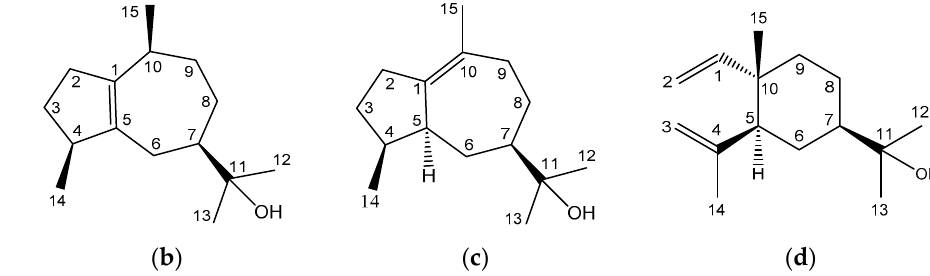
Figure 2. Chemical structures of sesquiterpenoids isolated from leaf essential oil. ( a ) 4,5-Epoxy- β - caryophyllene; ( b ) Guaiol; ( c ) Bulnesol; ( d ) β -Elemol. 4,5-Epoxy- β -caryophyllene: Colorless oil, EI-MS m/z: 79, 91, 105, 121, 145, 159, 173, 187, 202. Molecular formula: C 15 H 24 O. IR ν max cm − 1 : 2959 (C-H), 2920 (C-H), 1634